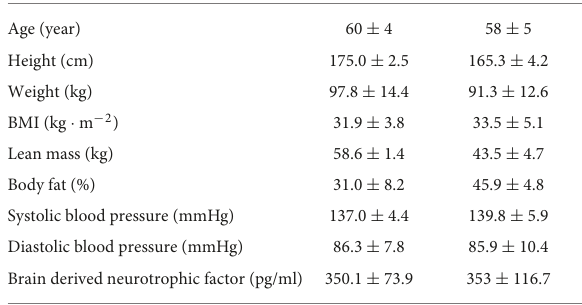
TABLE 1 Participant characteristics.